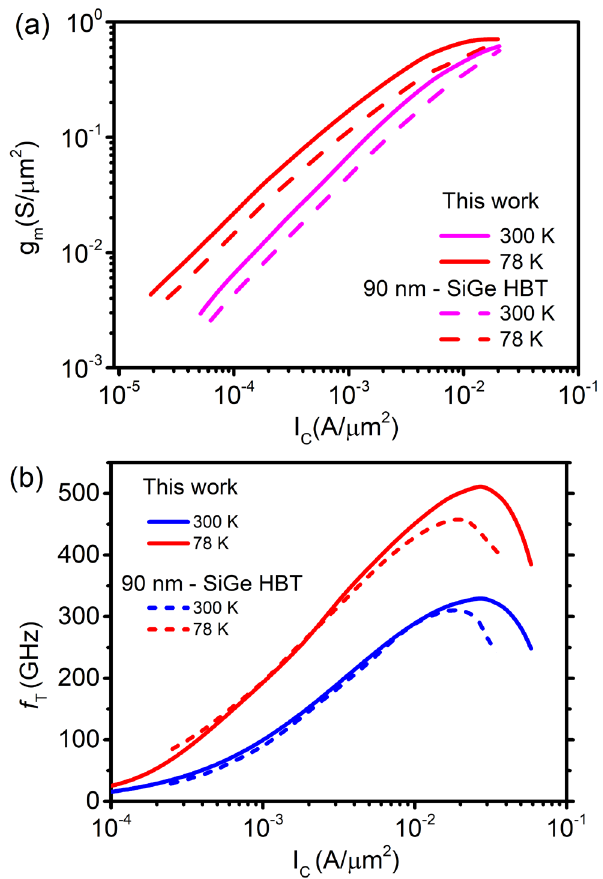
Figure 8. ( a ) The g m versus I C at V CB = 0 V; ( b ) the peak f T is comparatively larger in this work with respect to 90 nm SiGe HBT measurement data [8].